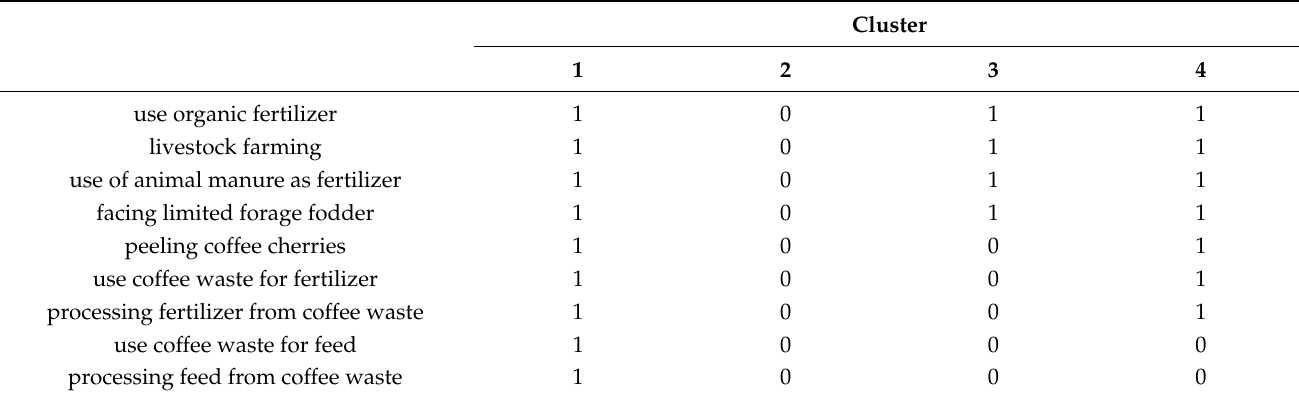
Table 8. Description of the final cluster.